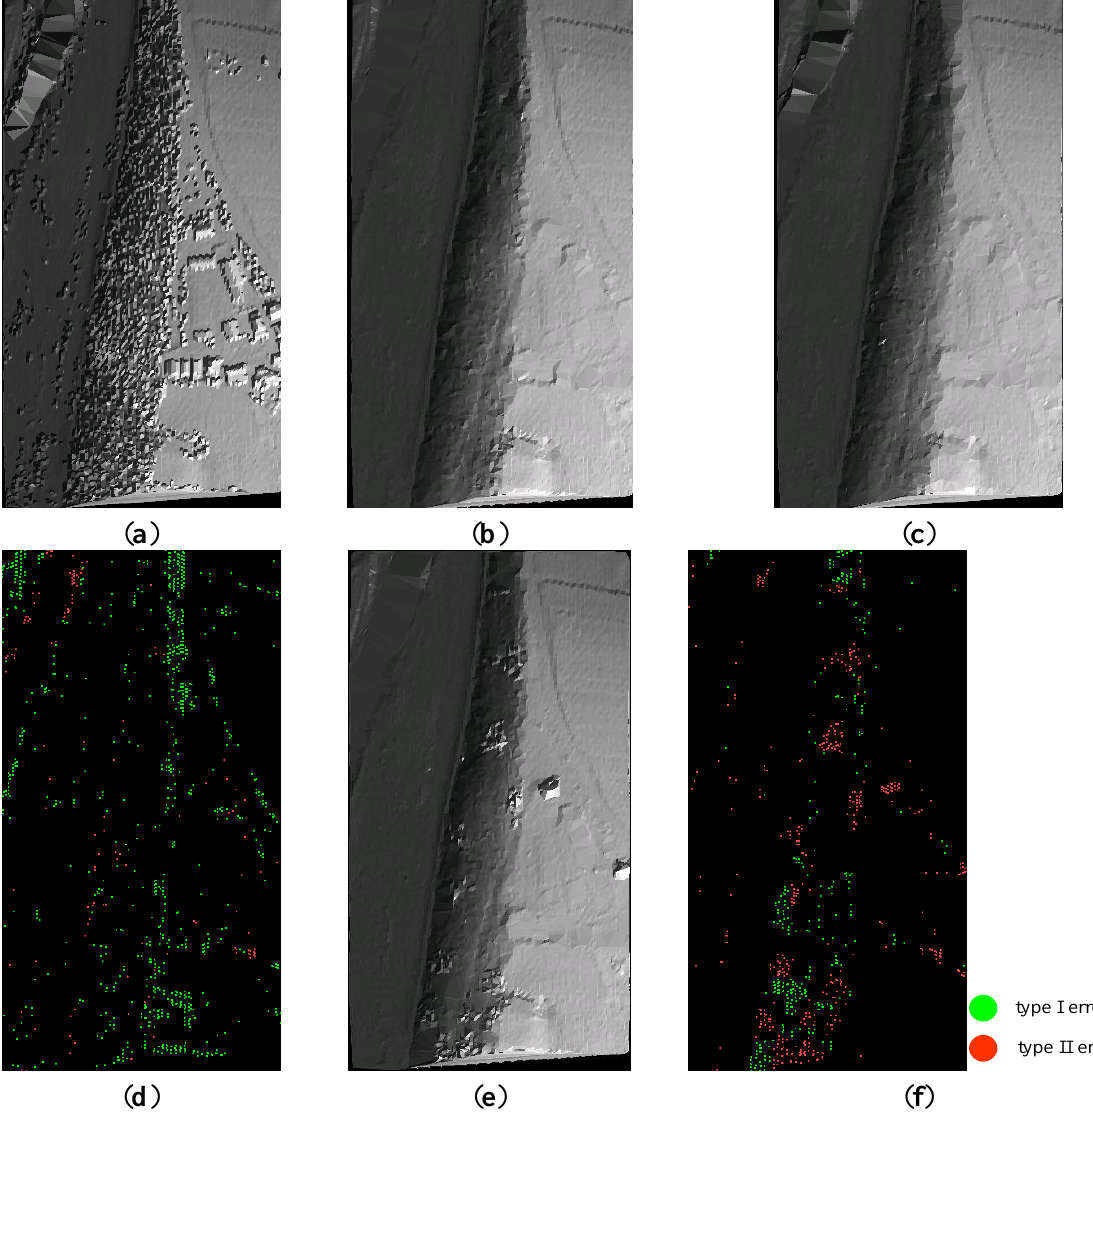
Figure 9. Filtering and results of reference data of Sample 51: ( a ) The DSM; ( b ) The reference DEM; ( c ) The DEM generated from the result of the PTD method; ( d ) The type I errors, type II errors of the PTD method; ( e ) The DEM generated from the result of the SBF method; ( f ) The type I errors, type II errors of the SBF method. Note that both of the DSM and the DEM are